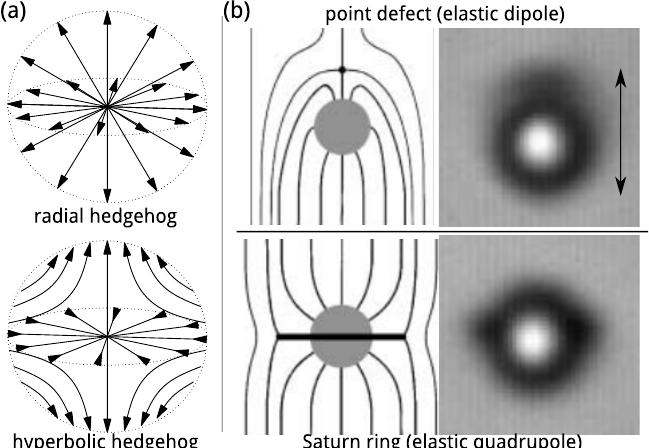
Figure 2. Topological charge. ( a ) The simplest nematic point defects: the radial and hyperbolic hedgehog. ( b ) A colloidal particle with an accompanying defect, forming an elastic dipole and an elastic quadrupole. The image ( b ) is reprinted and adapted with permission from the reference [38]– Copyright (2006)